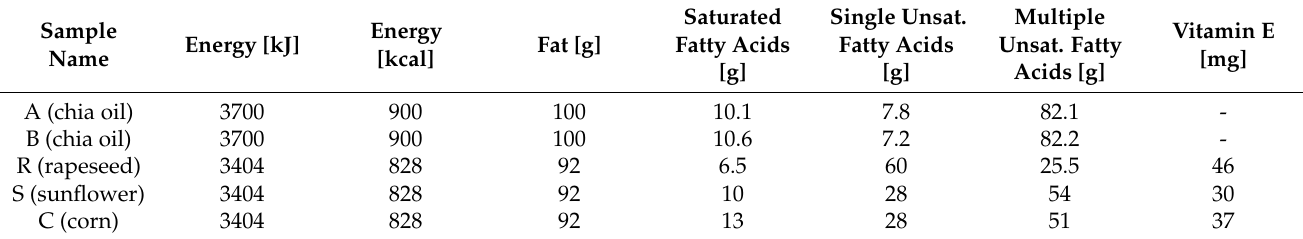
Table 1. T Nutritional values of the oil samples, for A and B (chia oils) per 100 g, for R, S and C per 100 mL. Sample